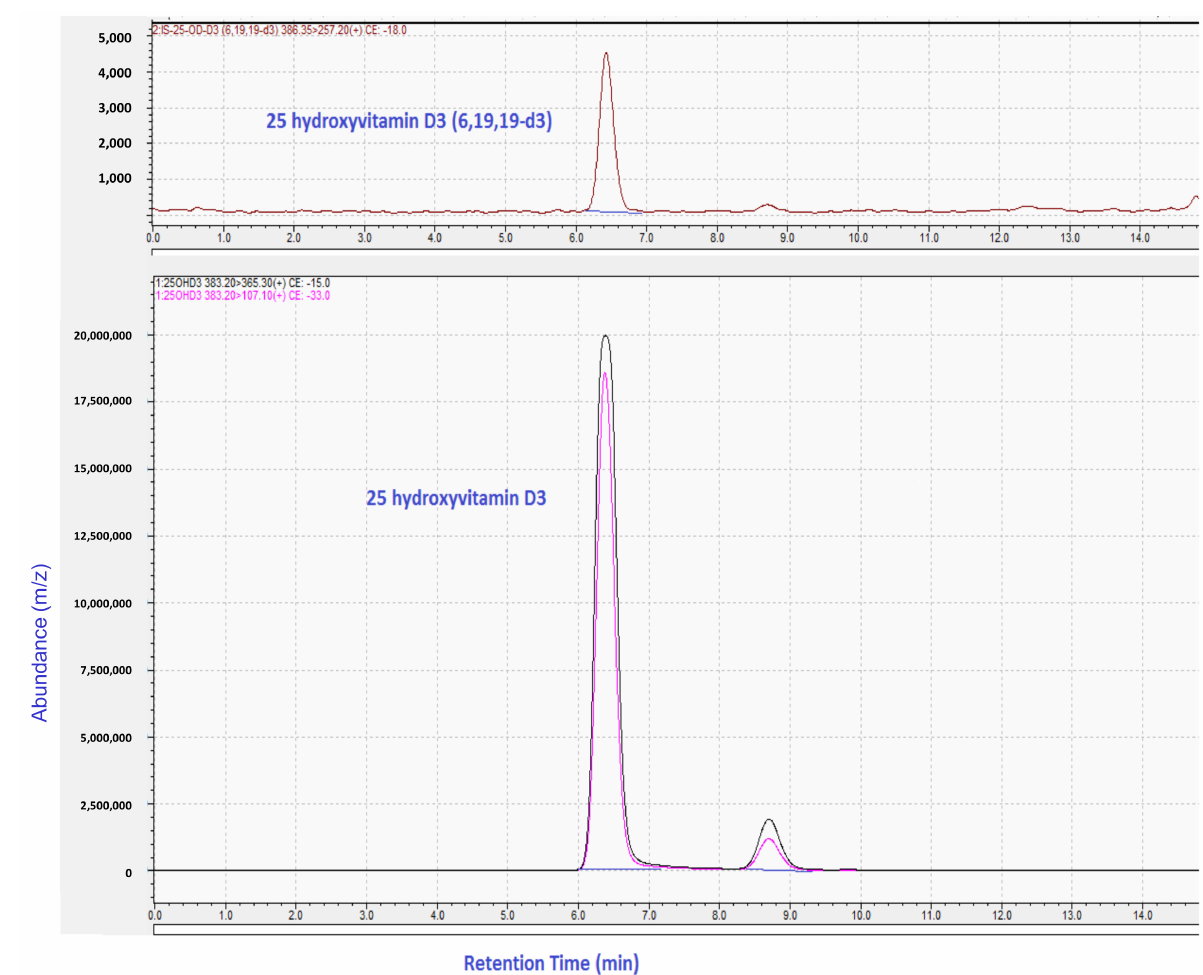
Figure 1. LC-MS/MS chromatogram showing retention time (top) and product ion mass spectrum of 25OHD 3 extracted from human hair matrix under investigation. Figure 1: LC-MSMS MRM spectra for the internal standard, 25 hydroxyvitamin D 3 (6,19,19-d3), [(386.35 → 257.20)], and 25 hydroxyvitamin D3 (383.20 → 365.3 and 383.30 →